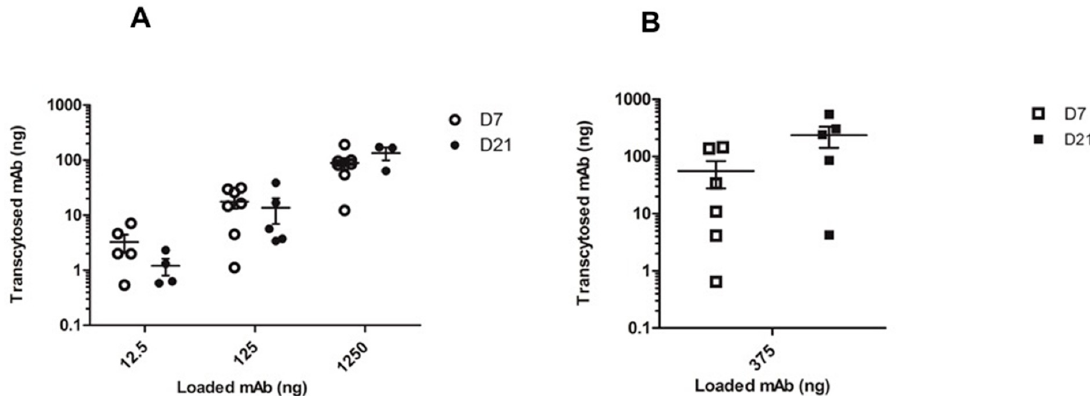
Figure 5. Monoclonal antibody (mAb) transcytosis through air–liquid interface culture of human nasal epithelial cells at day 7 and day 21 of different cell cultures ( n = 7) (954P, 955P, 956P, 959P, 994P, 997P, and 1002P). Transcytosis was tested in ( A ) apical-to-basal transport (on day 7—solid circles; on day 21— open circles) or ( B ) basolateral-to-apical transport (on day 7—solid squares; day 21—open squares). Results are expressed in absolute quantity of mAb in each compartment. Bars represent means +/ − SEM of the different experiments.